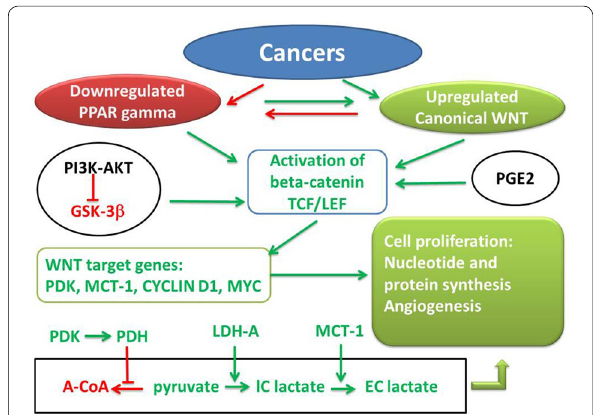
Fig. 2 Synthetic diagram of opposing effects of PPAR gamma and canonical WNT/beta‑catenin signaling in cancer. Green arrow activa‑ tion; red arrow inhibition; A ‑ CoA acetyl‑CoA, GSK ‑ 3beta glycogen synthase kinase‑3beta, IC lactate intracellular lactate, EC lactate extracellular lactate, GSK ‑ 3beta glycogen synthase kinase‑3beta, LDH ‑ A lactico‑dehydrogenase‑A, MCT ‑ 1 monocarboxylate lactate transporter‑1, PI3 K ‑ AKT phosphatidylinositol 3‑kinase‑protein kinase B, PDH pyruvate dehydrogenase, PDK pyruvate dehydrogenase kinase, TCF/LEF T‑cell factor/lymphoid enhancer factor, PPAR gamma peroxisome proliferator‑activated receptor